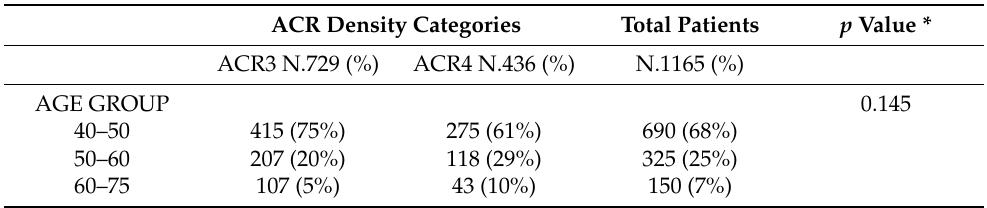
Table 1. Patient’s age and American College of Radiology (ACR)